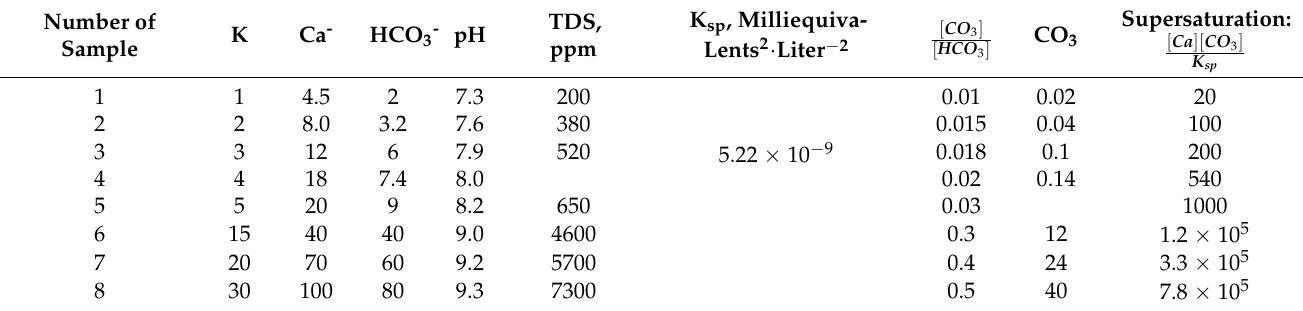
Table 1. Determination of calcium carbonate supersaturation values, reached in “dead” areas at different recoveries (and values of coefficient K).